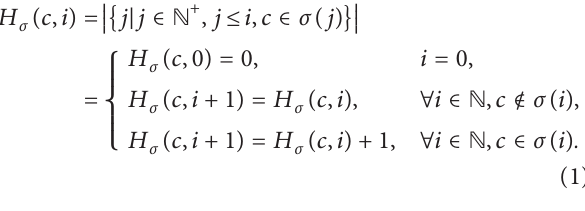
and blue arrows, which stand for causalities (weakly synchronous).